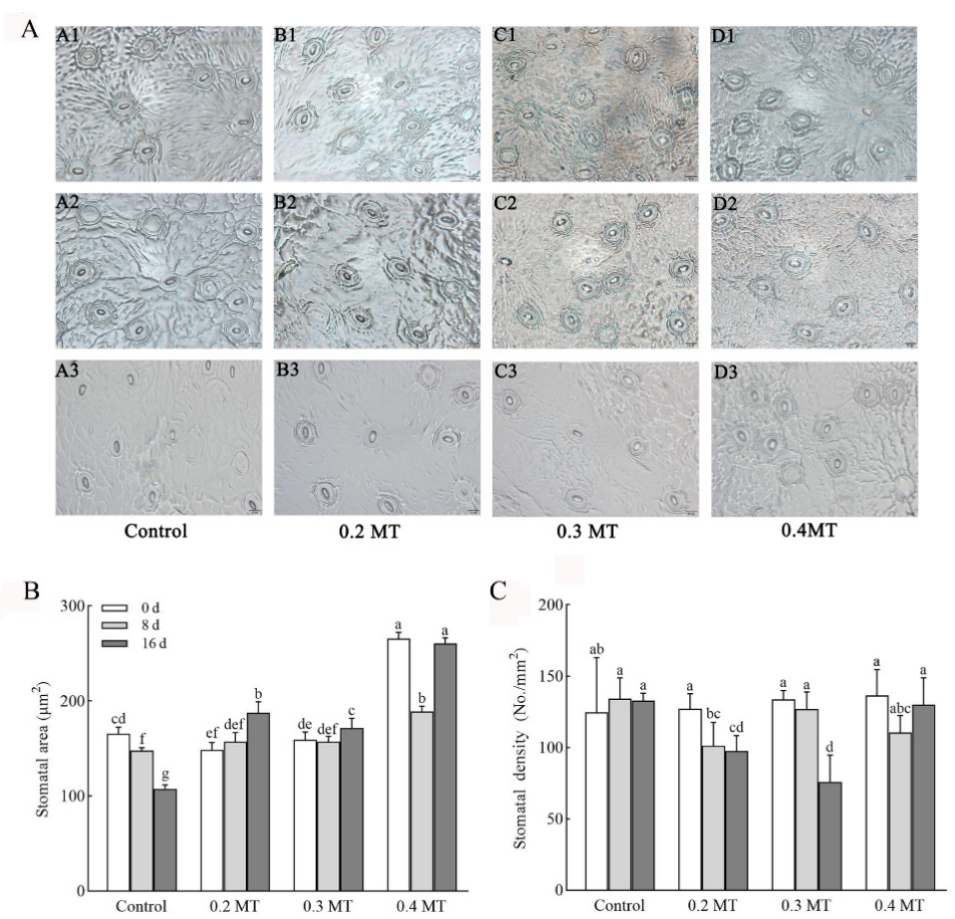
Figure 2. Effect of exogenous MT on stomatal morphology ( A ) stomatal area ( B ), and density ( C ). A, B, C, and D represent control group, 0.2 mM MT, 0.3 mM MT, and 0.4 mM MT treatment groups, respectively. A1, A2, and A3 represent control treatment at days 0, 8, and 16, respectively. The rest can be done in the same manner. Scale bars = 20 µm. Data are shown as means ± SD in three independent replicates. Different superscript letters indicate significant differences between different treatments at p < 0.05 level.